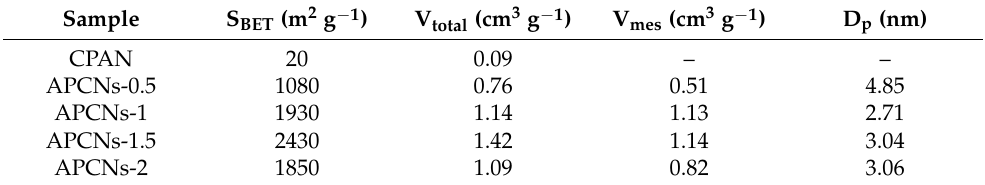
Table 4. Pore properties of porous carbon materials with different activation holding time in one-step activation